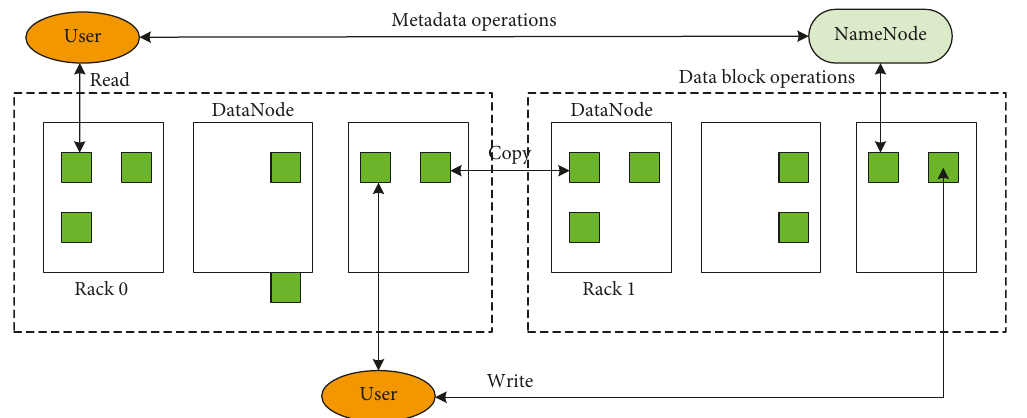
Figure 2: Structure sketch map of